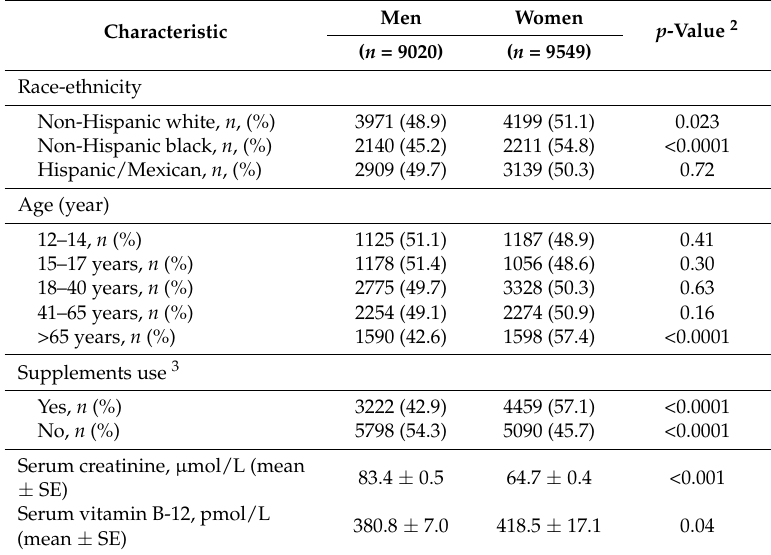
Table 1. Characteristics of study population: National Health and Nutrition Examination Survey (NHANES), 1999–2004 1